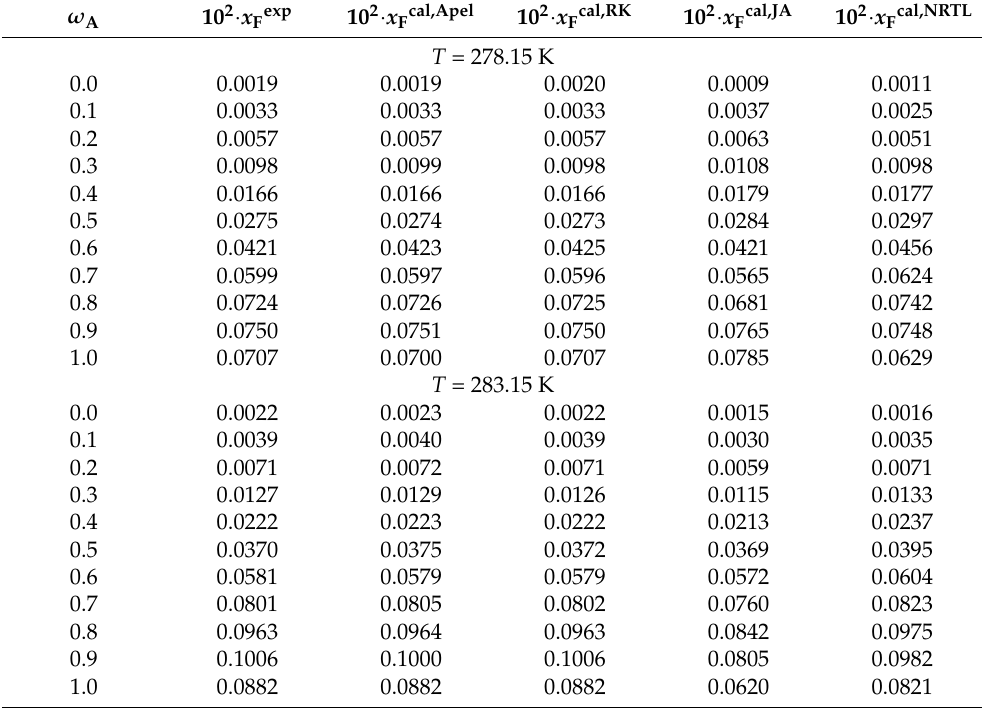
Table 4. Experimental and calculated molar ratio solubility of florfenicol in binary solvent mixtures of isopropanol + water from T = 278.15 to 318.15